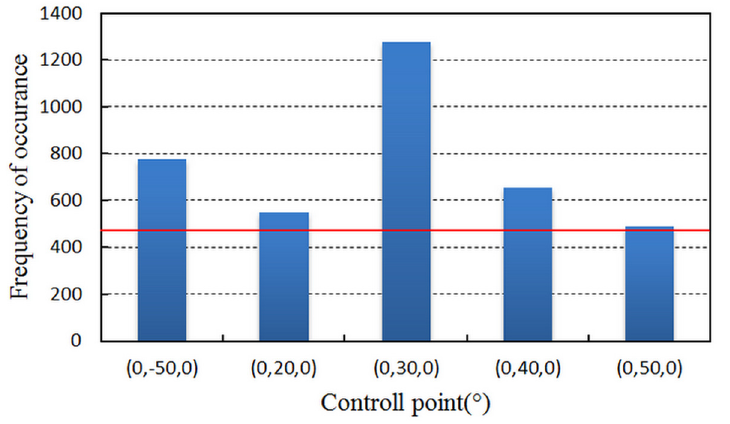
Fig 11. The frequency of occurrence of M III . Only the filtered control points are displayed. The red line is the cutoff frequency.